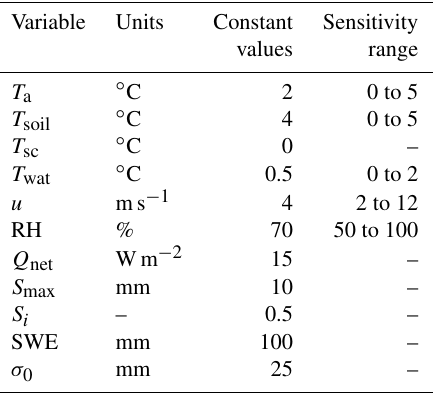
Table 2. Input variables for scenario analysis of SLHAM